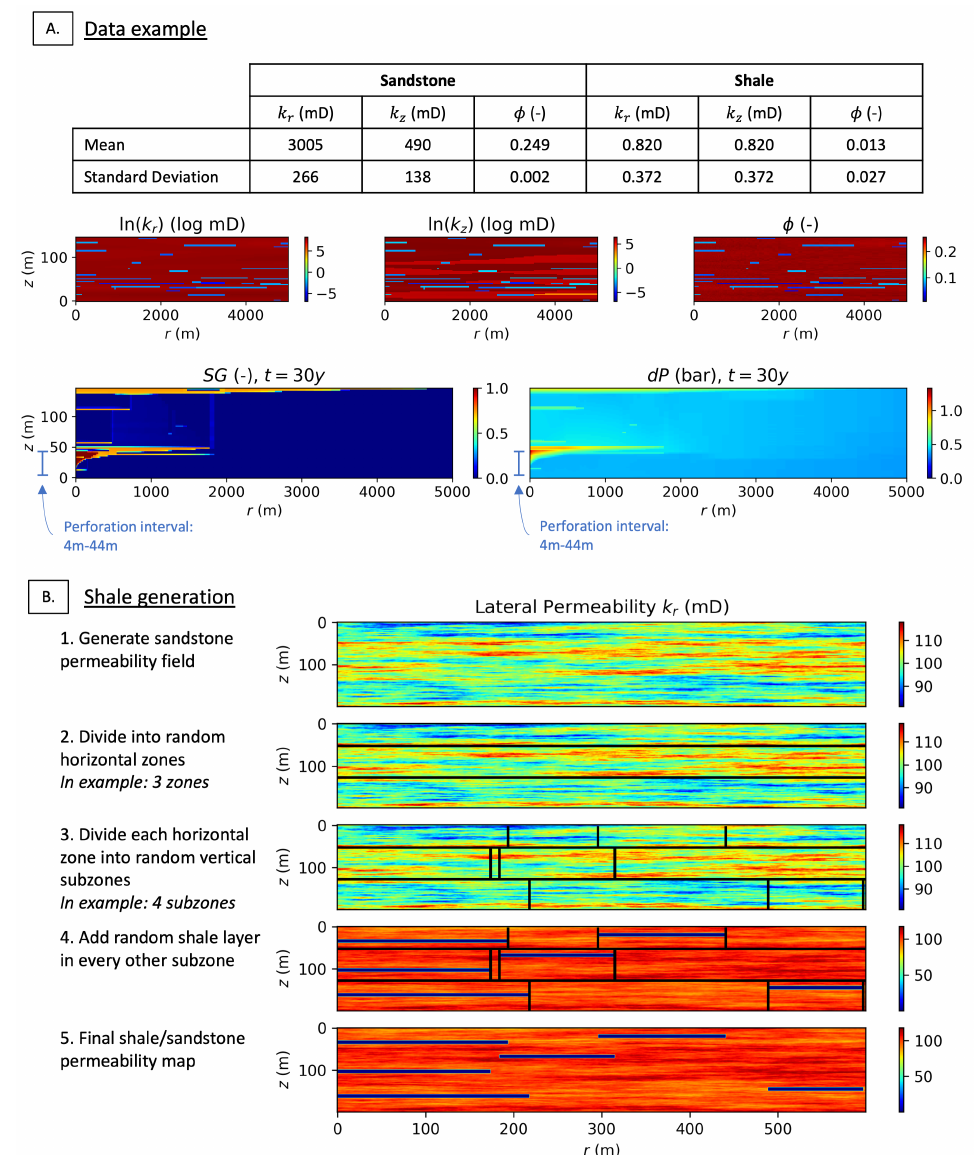
Figure 1. ( A ) Examples of the data input and output used in this study: the lateral permeability k r , the vertical permeability k z , the porosity φ , the gas saturation SG , and the pressure buildup dP . ( B ) The procedure of generating a sandstone field and imposing a random shale field onto it. This simplified example uses three horizontal zones and four vertical subzones for visual